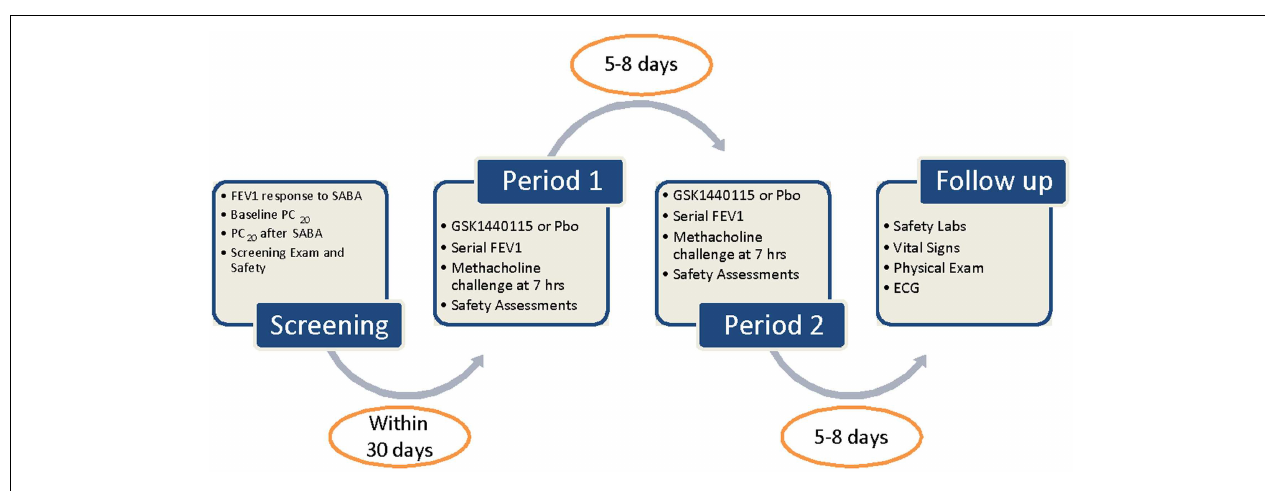
FIGURE 1 | Study schematic . SABA, short acting β 2